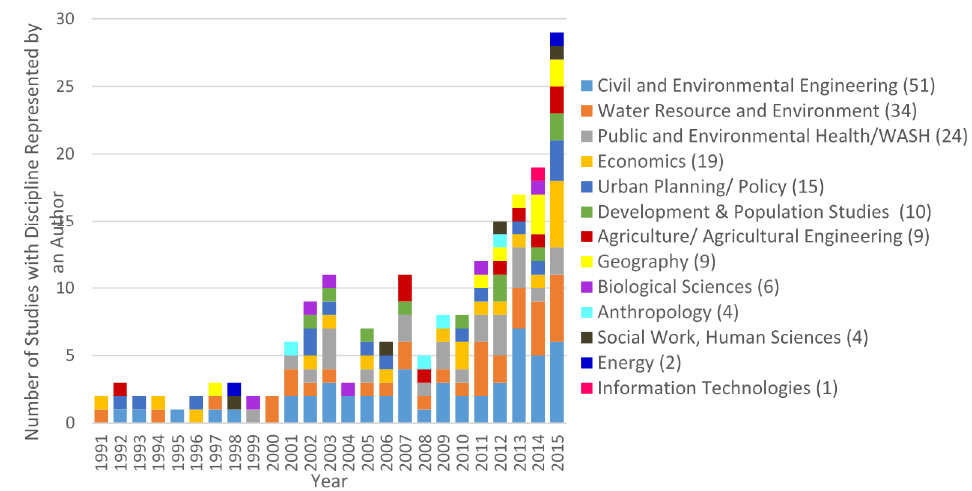
Figure 2. Disciplines represented by authors of intermittent water supply studies 1991–2015 (total number of studies = 126; numbers in parentheses are the number of times each discipline appeared in the author lists) [1–25,27–64,66–125,127–129].